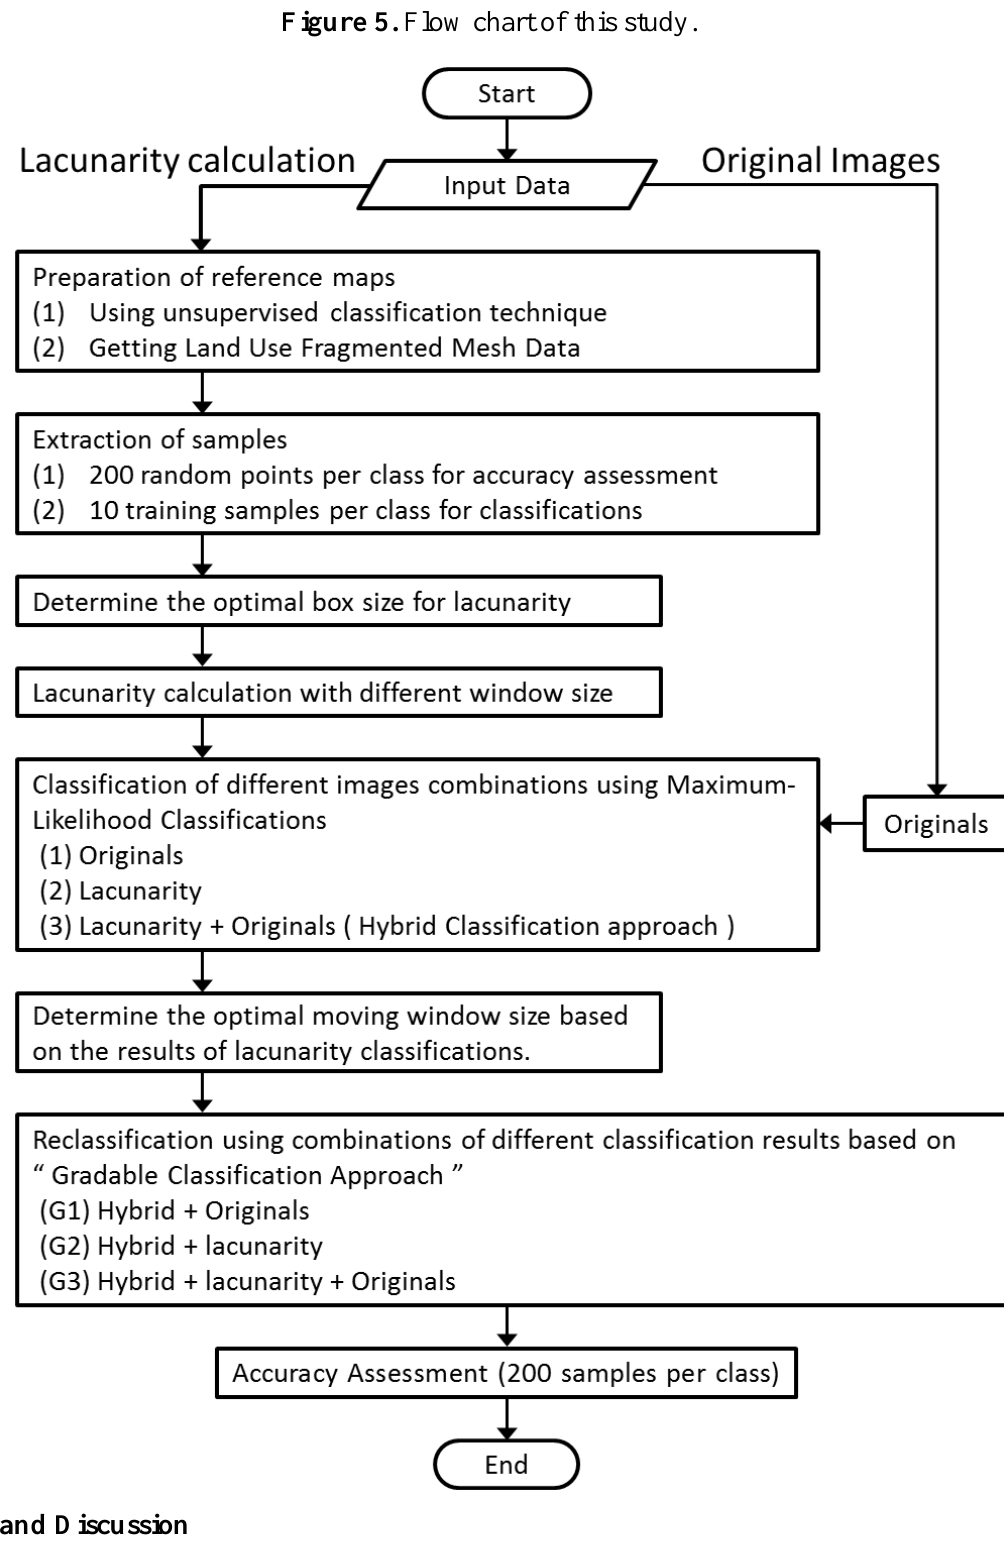
Figure 5. Flow chart of this